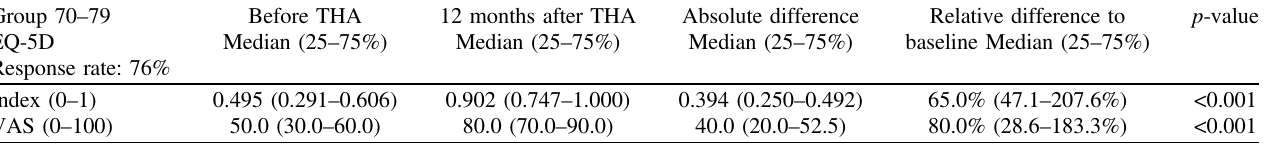
Table 9. EQ-5D index score and VAS before and after THA in the group 70 – 79.